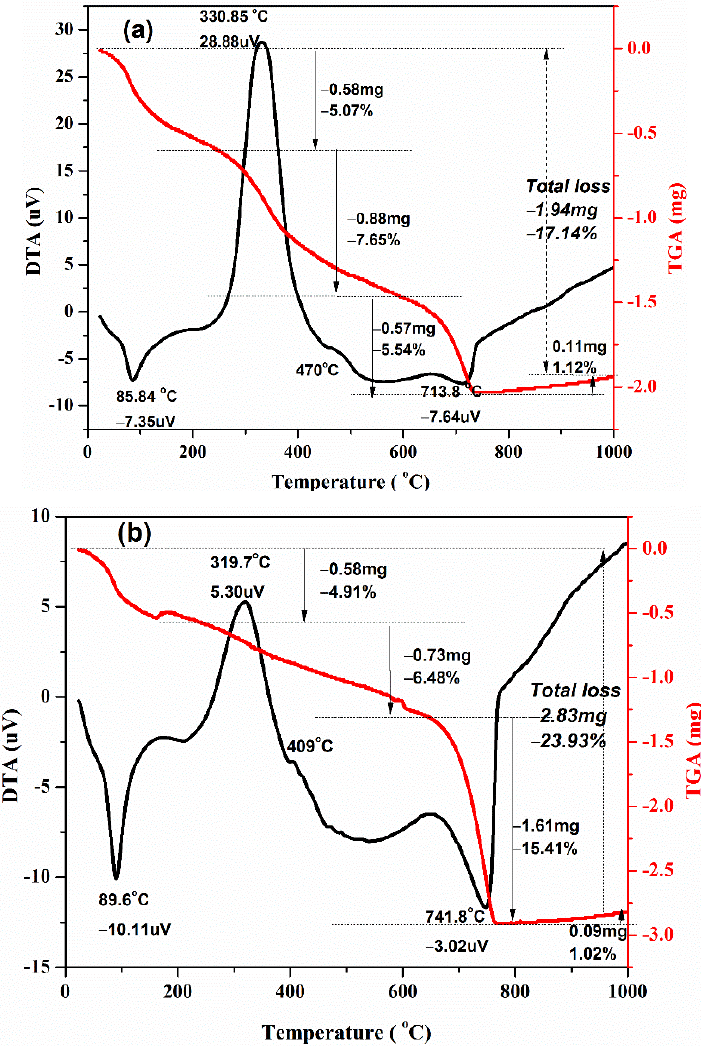
Figure 11. TGA and DTA curves for mortar samples: ( a ) conventional mortar; ( b ) self-healing mor- tar.